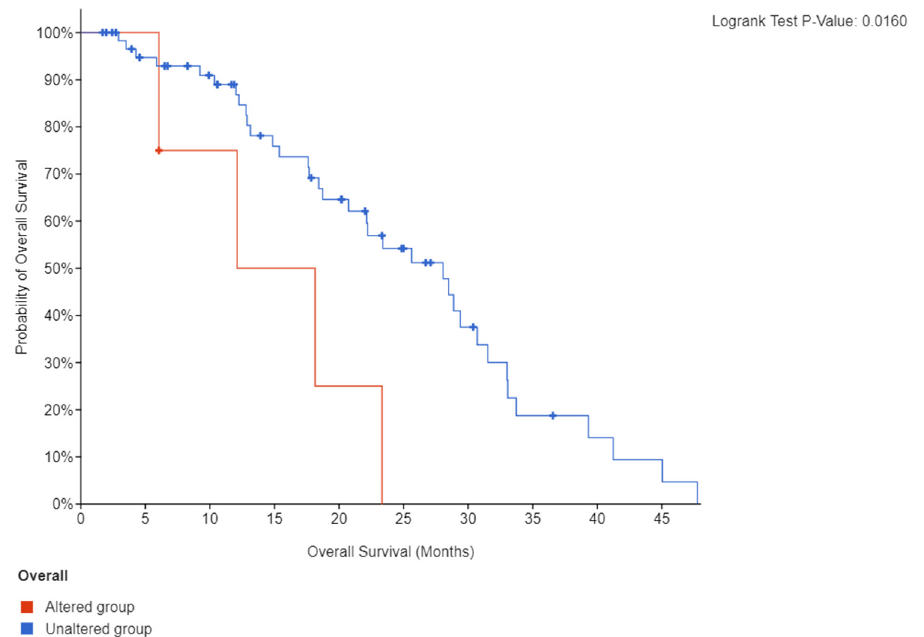
Figure 4. Kaplan-Meier curve of OS according to FAP mRNA expression (high vs. unaltered). To validate our findings in other tumor types, we assessed FAP mRNA expression across 947 human cancer cell lines from the Cancer Cell Line Encyclopedia (CCLE) [16]. The highest transcript levels above a z-score of 1.0 were found in melanoma (64.4% of 59 cell lines) and glioma (58.7% of 46 cell lines) (Figure 5A). We thus sought to examine the prognostic utility of high FAP mRNA in two independent cohorts of melanoma ( n = 64), and glioblastoma ( n = 155) from The Cancer Atlas Database (TCGA) [17,18]. High FAP mRNA was found in 10% and 4% of tumors, respectively, and was associated with shorter median OS (melanoma cohort: 5.5 vs. 32.4 mos, p = 0.046; glioblastoma cohort: 10.4 vs. 14 mos, p = 0.024) (Figure 5B–D).